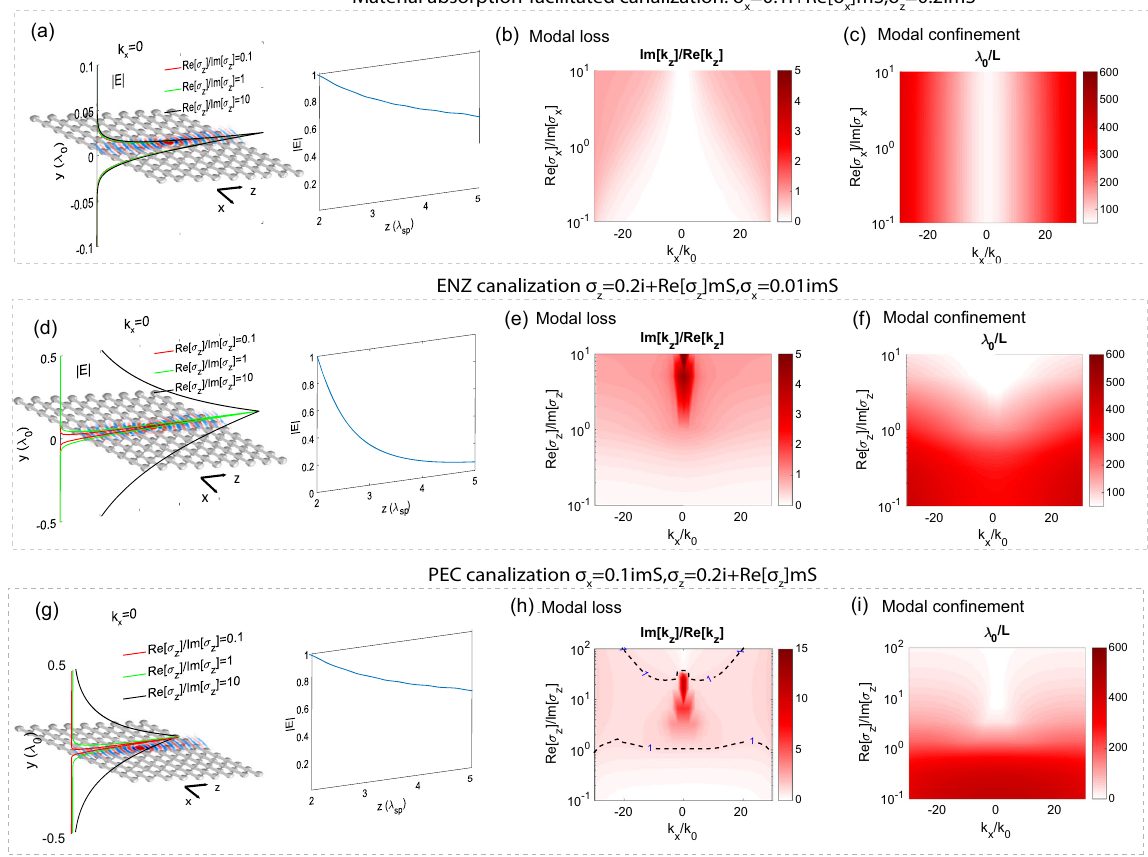
Fig. 3 Loss-con fi nement for different canalized schemes. Comparison of modal loss ( Im k z ½ (cid:3) = Re k z ½ (cid:3) ) and con fi nement ( L / λ 0 ) in different 2D canalized platforms based on: ( a ) – ( c ) material absorption shown in this work ( d ) – ( f ) ENZ effect, and ( g ) – ( i ) PEC effect. Larger penetration depth ( L ) will lead to weaker modal con fi nement. a Schematic, penetration depth as function of material absorption ( k x ¼ 0 ), and the power attenuation ( σ x,z = 0.1i + 0.06, 0.2imS) of the canalized fi eld in anisotropic 2D materials facilitated by material absorption. b Modal loss and ( c ) modal con fi nement of anisotropic 2D modes as functions of k x = k 0 and material absorption. It is seen that a broad range of low-loss k x modes can still be supported even with the introduction of material absorption, while the modal con fi nement remains largely non-impacted as shown in ( a ). d Schematic, penetration depth, and the power attenuation of the canalized fi eld facilitated by ENZ metasurface ( σ x,z = 0.2i + 0.06, 0.001imS), where it is seen that the propagation distance will be greatly curtailed with the introduction of material absorption. e Modal loss and ( f ) modal con fi nement of ENZ metasurface as functions of k x = k 0 and material absorption. The performance of modal loss and modal con fi nement will be degraded with the increase of material absorption, particularly in small k x regime. g Schematic, penetration depth, and the power attenuation of the canalized fi eld facilitated by PEC effect. It is seen that the modes operated in PEC condition will become loosely guided, losing subwavelength feature offered by 2D plasmonics. h Modal loss and ( i ) modal con fi nement of PEC metasurface as functions of k x = k 0 and material absorption. As can be seen, the modal loss can be reduced however the modal con fi nement will be degraded in the PEC